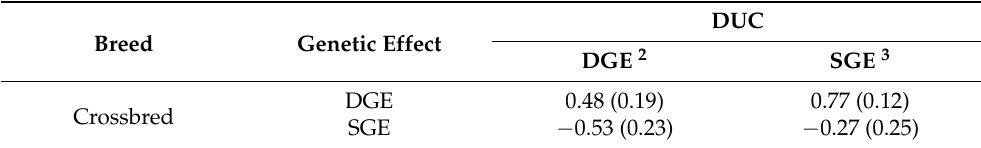
Table 2. Genetic correlations 1 (posterior standard deviations) between DUC and crossbred